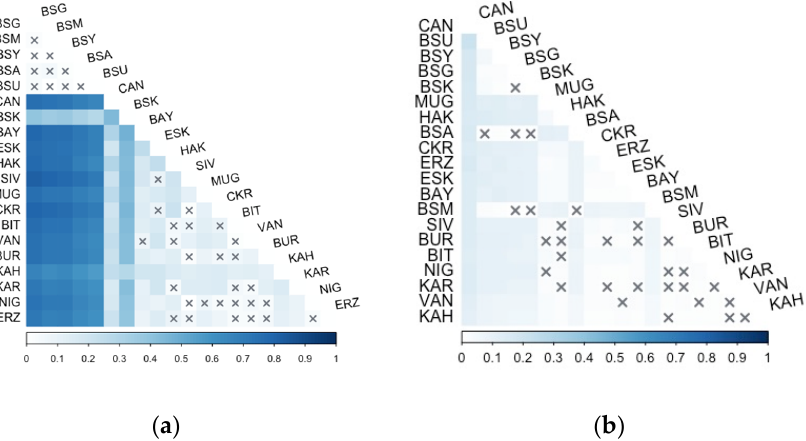
Figure 2. Heat map of mitochondrial ( a ) and microsatellite ( b ) pairwise F ST values across A. chukar populations in Turkey. Darker shades of blue rectangles indicate higher values of F ST (as displayed on the bar down of the heat map). Crosses indicate non-significant F ST p -values ( p > 0.05). Table 3. Spatial analysis of molecular variance (SAMOVA) of Alectoris chukar for the mtDNA. K , number of groups. F CT , the proportion of total genetic variance due to the differences between groups. Captive and wild populations’ K was given in the first